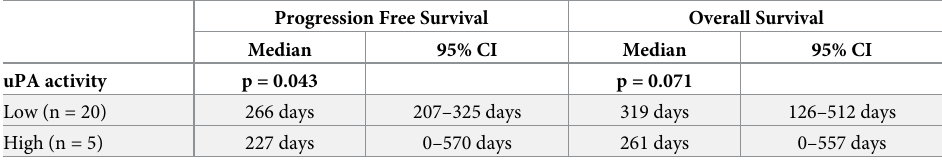
Table 3. Survival times of osteosarcoma-bearing dogs with low or high serum uPA activity.